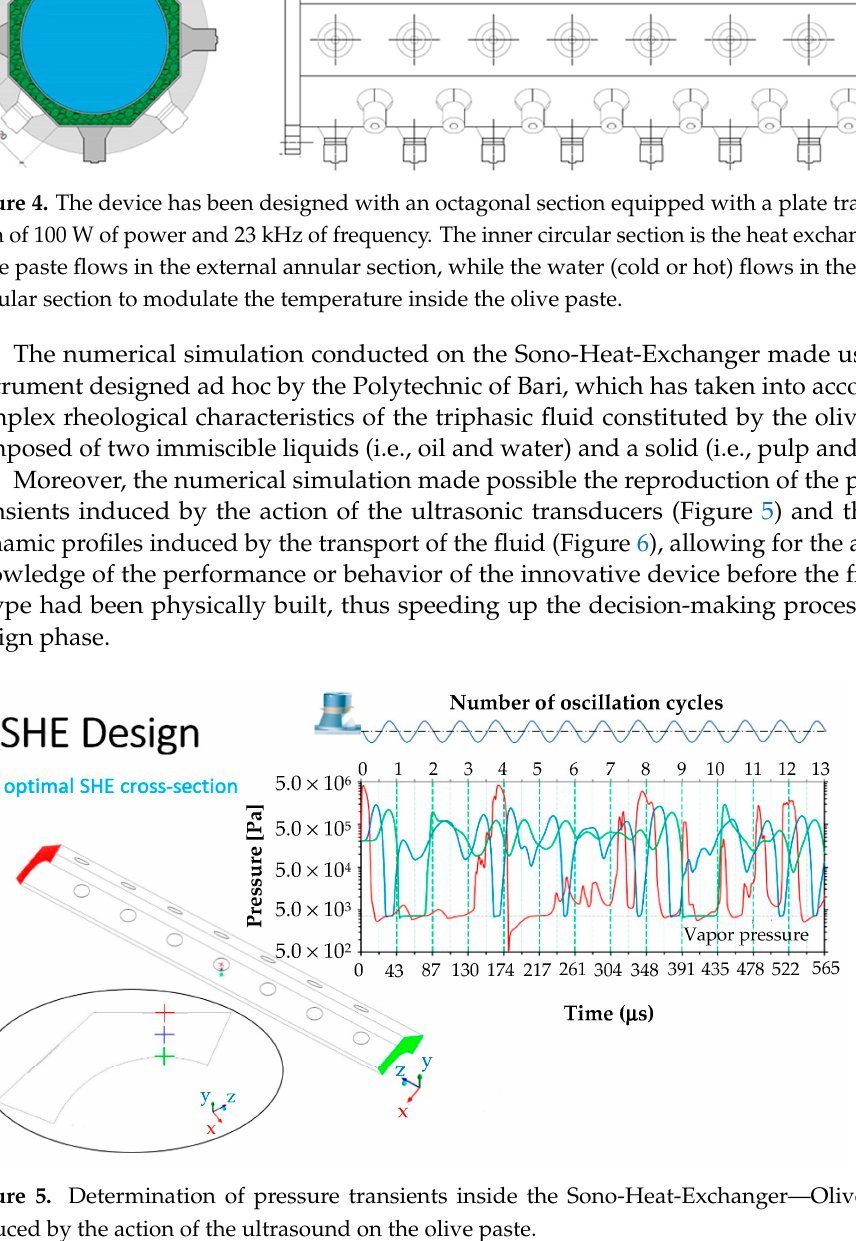
Figure 6. Fluid dynamic analysis of the olive paste inside the Sono ‒ Heat ‒ Exchanger—Olive Sound. Finally, the numerical simulation made it possible to highlight two important effects of the ultrasound on the olive paste that explain the theoretical basis of the effects meas- ured in the experimental phase. The first effect is the increase in yield and polyphenol content due to the determination of the pressure transients in the predetermined operat- ing conditions. Indeed, the minimum pressure values reached inside the olive paste are below the vapor pressure of the water at the process temperature (~ 25 °C); therefore, they are compatible with effective cavitation (formation and collapse of vapor microbubbles) and useful for breaking the cells of the drupe passed intact to the crusher and for freeing the oil and minor compounds (polyphenols, tocopherols and carotenoids) trapped in them. The second effect deals with the elimination of the malaxer because the pulsating action of the transducers causes swirling movements on the olive paste that agitate the flow of olive paste in transit in the apparatus, inducing agitation similar to that inside the malaxer and favoring coalescence phenomena among the minute drops of oil released by